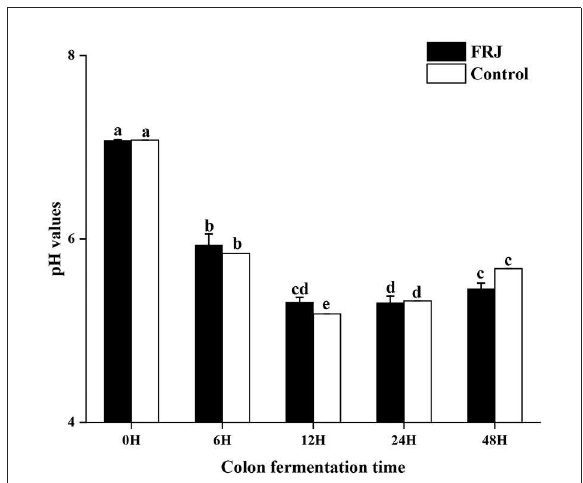
FIGURE7 pH value of the colonic fermentation stage. Different letters (a–e) mean significant difference ( p < 0.05).